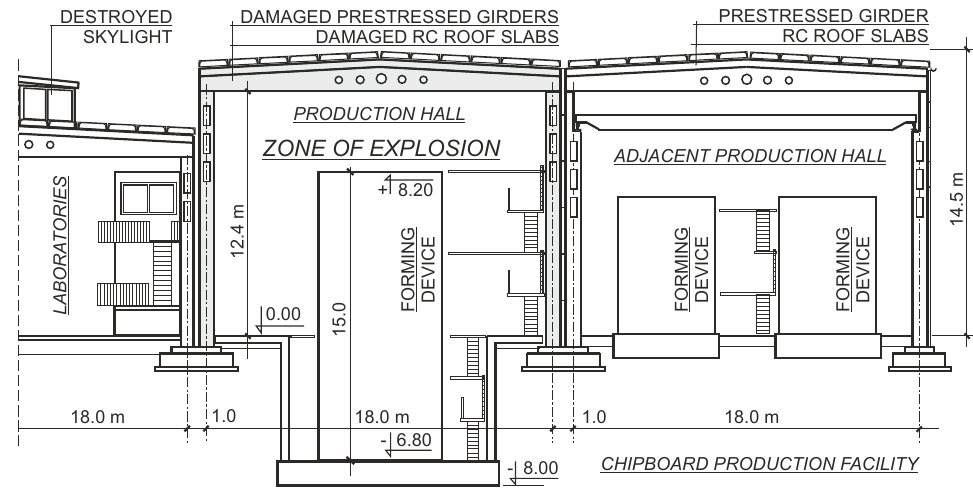
Figure 6. Cross − section of the damaged production hall.